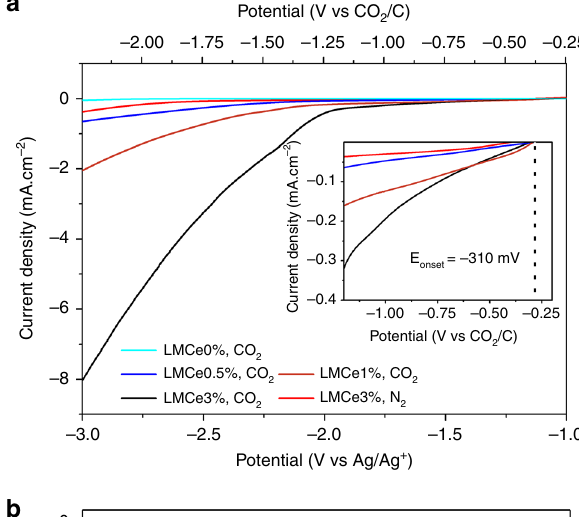
Fig. 1 Characteristics of CO 2 reduction by the LMCe electrocatalyst. a linear sweep voltammogram (LSV) of galinstan with different concentrations of Ce measured in 0.1 M tetrabutylammonium hexa fl uorophosphate (TBAPF 6 ) and 2 M H 2 O in dimethylformamide (DMF) in N 2 and CO 2 saturated electrolyte. Inset shows a magni fi ed view. b Chrono-amperometry results of liquid galinstan and solid gallium containing 3% Ce measured at − 3 V